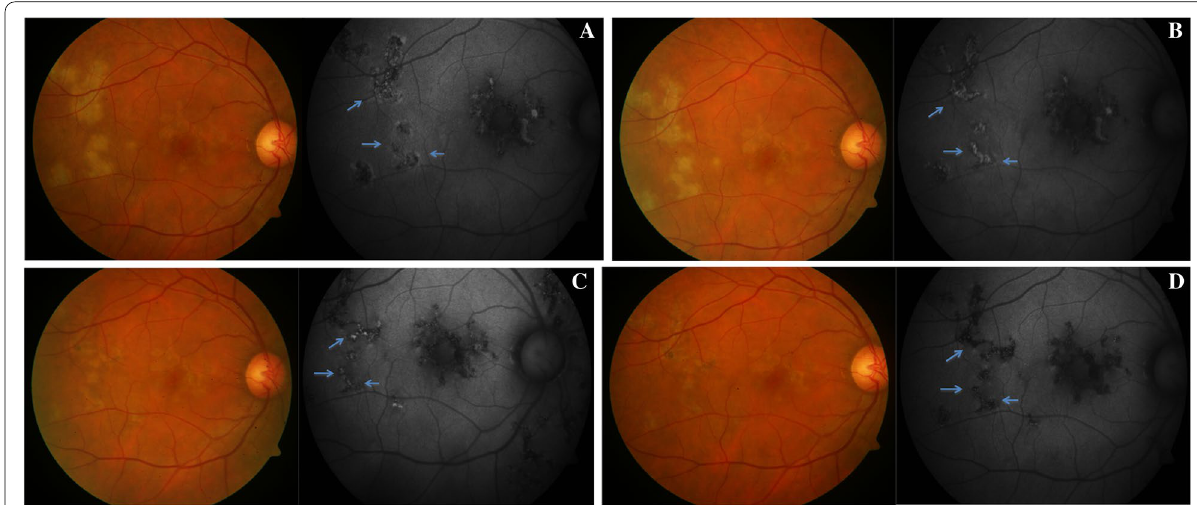
Fig. 4 Color fundus photograph (left panel) showing active lesions of TBSLC and fundus autofluorescence (right panel) showing stage I (acute) lesions (blue arrows), characterized by an ill-defined, diffuse halo of hyper autofluorescence along the active lesion ( a ). In stage II (subacute), a thin hypoautofluorescent rim (blue arrows) appears at the border of the lesion as it begins to heal, and the central hyperautofluorescence becomes prominent ( b ). In stage III, as the central hyper autofluorescence decreases and peripheral hypoautofluorescence increases (blue arrows), the lesion appears stippled ( c ). In stage IV, with complete healing of the lesion over several months, there is generalized hypo autofluorescence (blue arrows) ( d